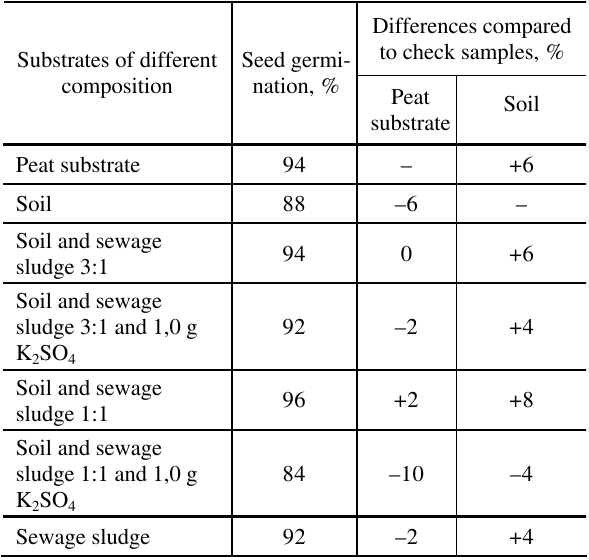
Table 1. Seed germination data from substrates of different